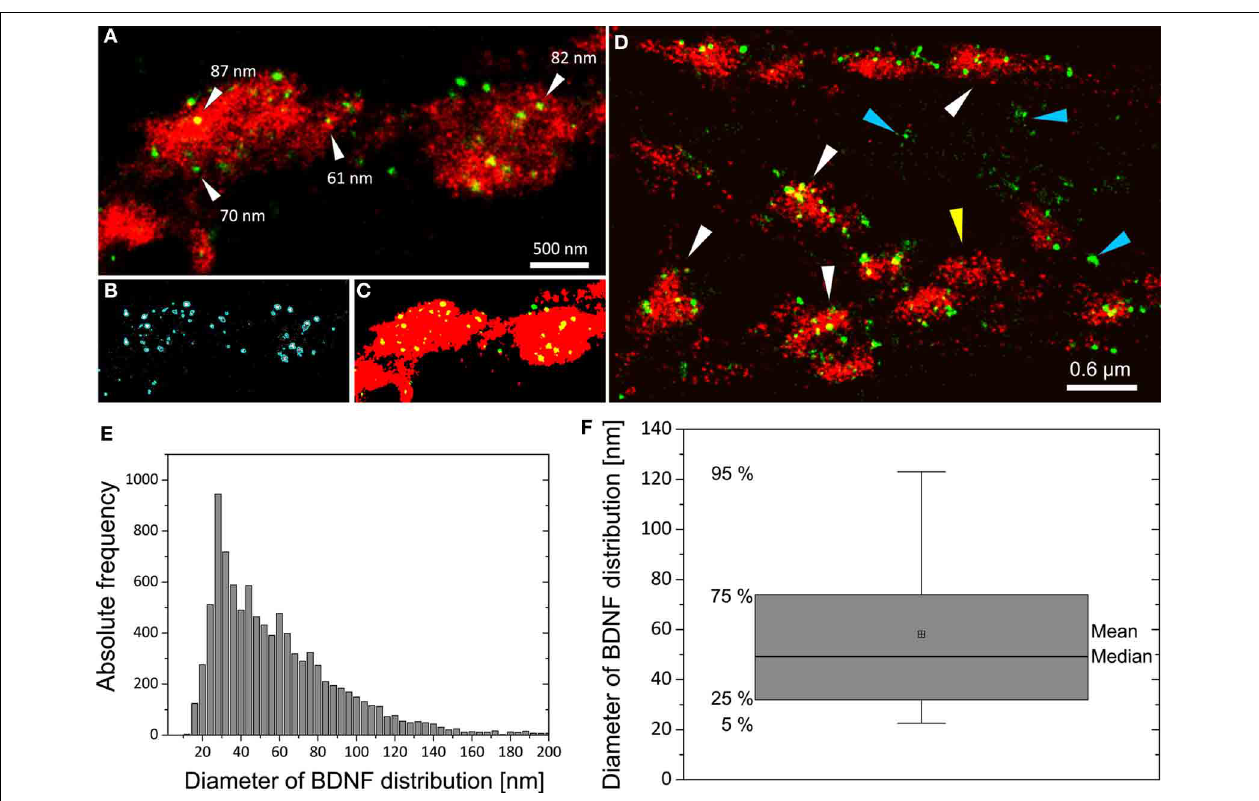
FIGURE 7 | Distribution pattern of BDNF + immunoreactivity in d STORM images and quantitative analysis of BDNF granules. (A) In vGlut + structures BDNF localizations appear as well-separated spherical structures. (B) Definition of the BDNF + distribution within localizations masks (cyan mask). (C) Transformation of grayscale image information to a binary information (red vGlut + , green BDNF, yellow color represents the overlap of both labels). Here, 91% of all BDNF localizations overlap with the vGlut + mask. (D) vGlut + synapses containing densely packed BDNF + vesicles (white arrows) and vGlut + discs with low amount of BDNF + vesicles (yellow